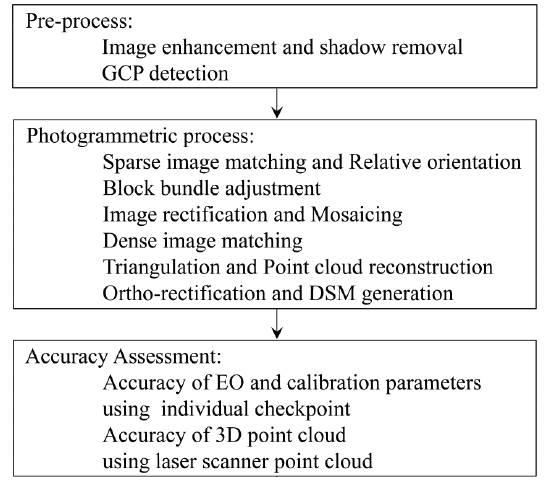
Figure 8. Photogrammetric workflow to produce topographic data from